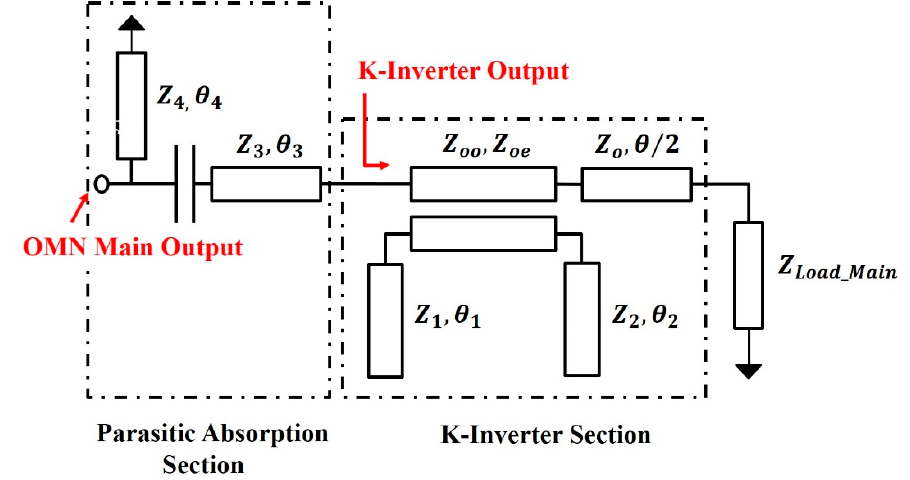
Figure 9. Main Amplifier portion of the output power combiner.